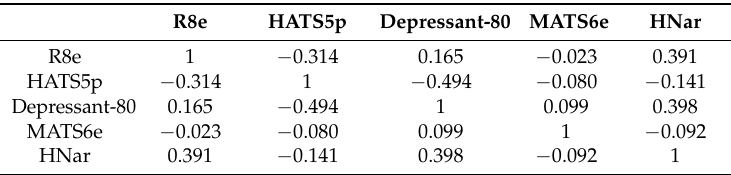
Table 4. The correlation matrix of